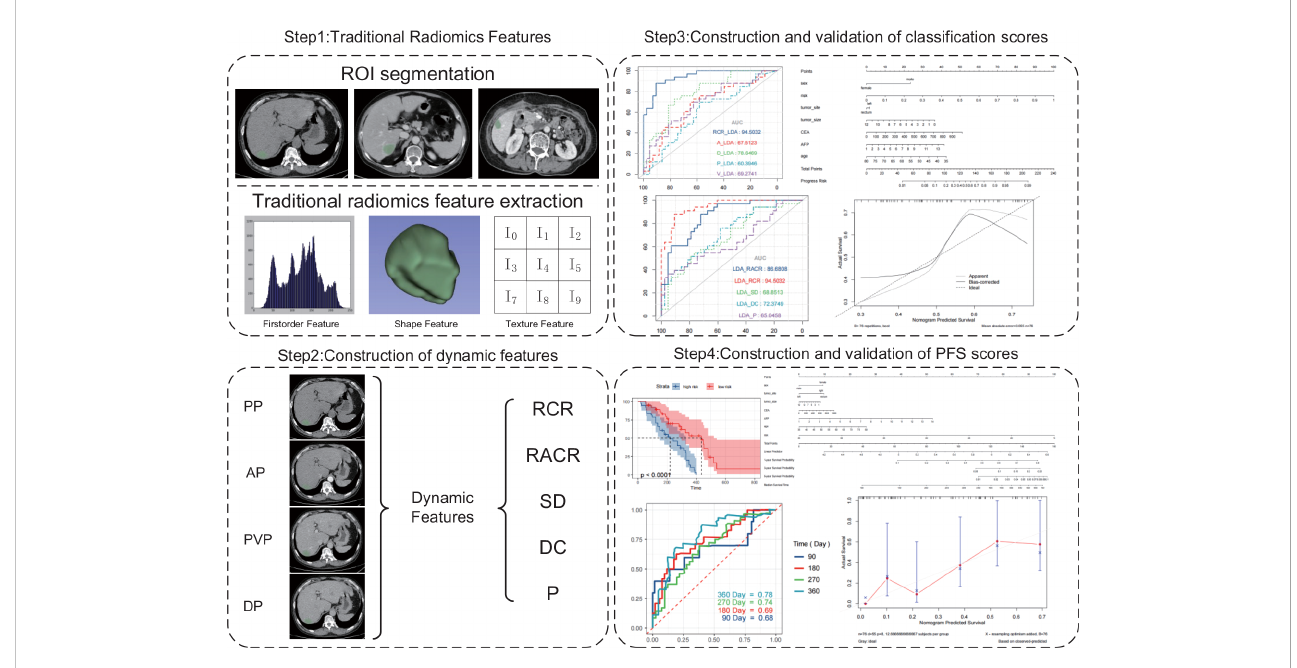
FIGURE 2 Work fl ow of the necessary steps in this study.